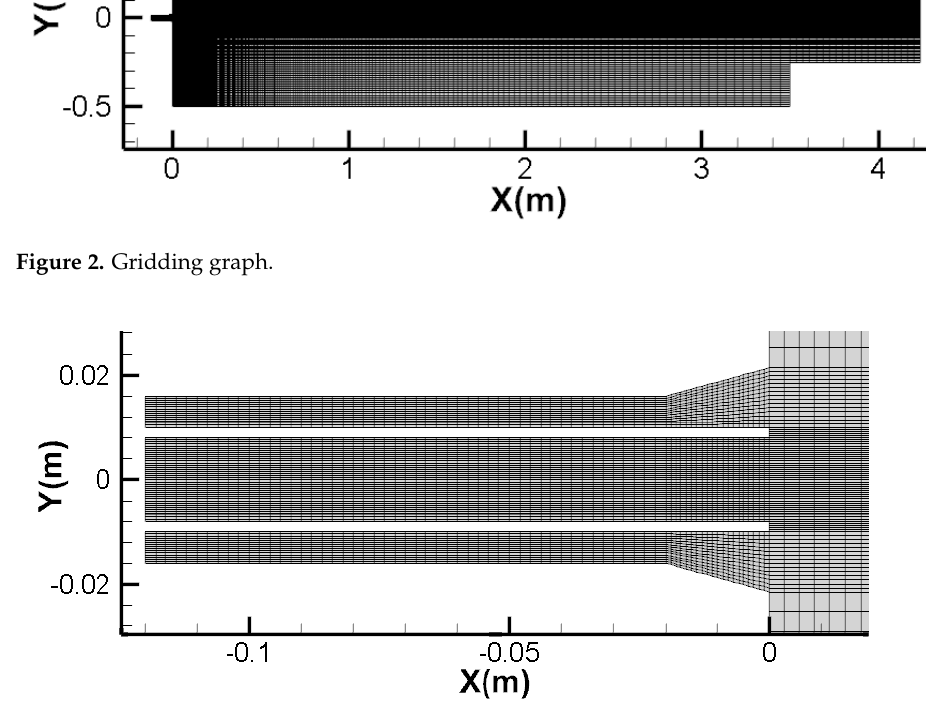
Figure 3. Details of the grid at the nozzle.